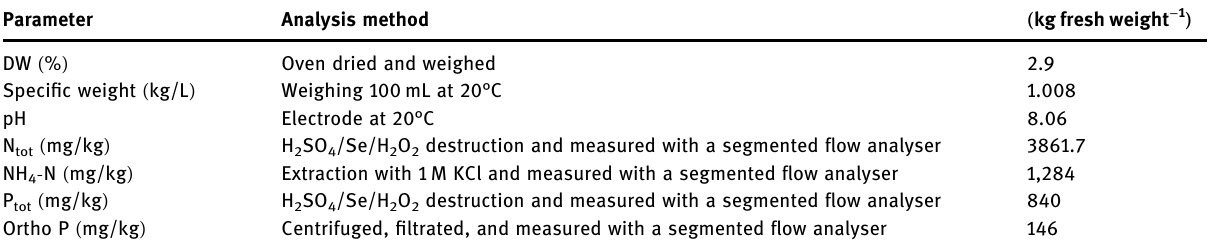
Table 2: Properties of the pig slurry Parameter Analysis